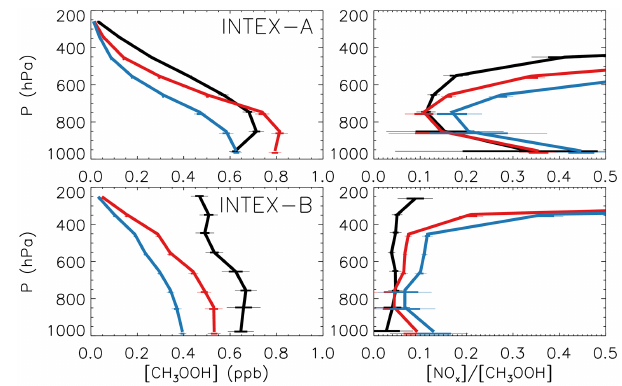
Figure 13. Vertical profiles of CH 3 OOH and the NO x : CH 3 OOH ratio over North America. Shown are the mean measured (black) and simulated (colored) values during the INTEX-A (Singh et al., 2006) and INTEX-B (Singh et al., 2009) flight cam- paigns. Red lines show results from the GEOS-Chem base- case simulation, while the blue lines show results from a sensitivity run that includes the CH 3 O 2 + OH reaction at = 2.8 × 10 − 10 cm 3 molec − 1 s − 1 (Bossolasco et al., k CH 3 O 2 + OH 2014). Horizontal lines indicate ± 1 (thick) and ± 2 (thin) standard errors about the